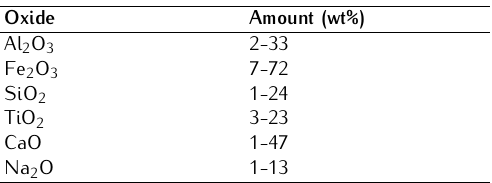
Table 3. Average chemical composition of red mud; expressed as oxides